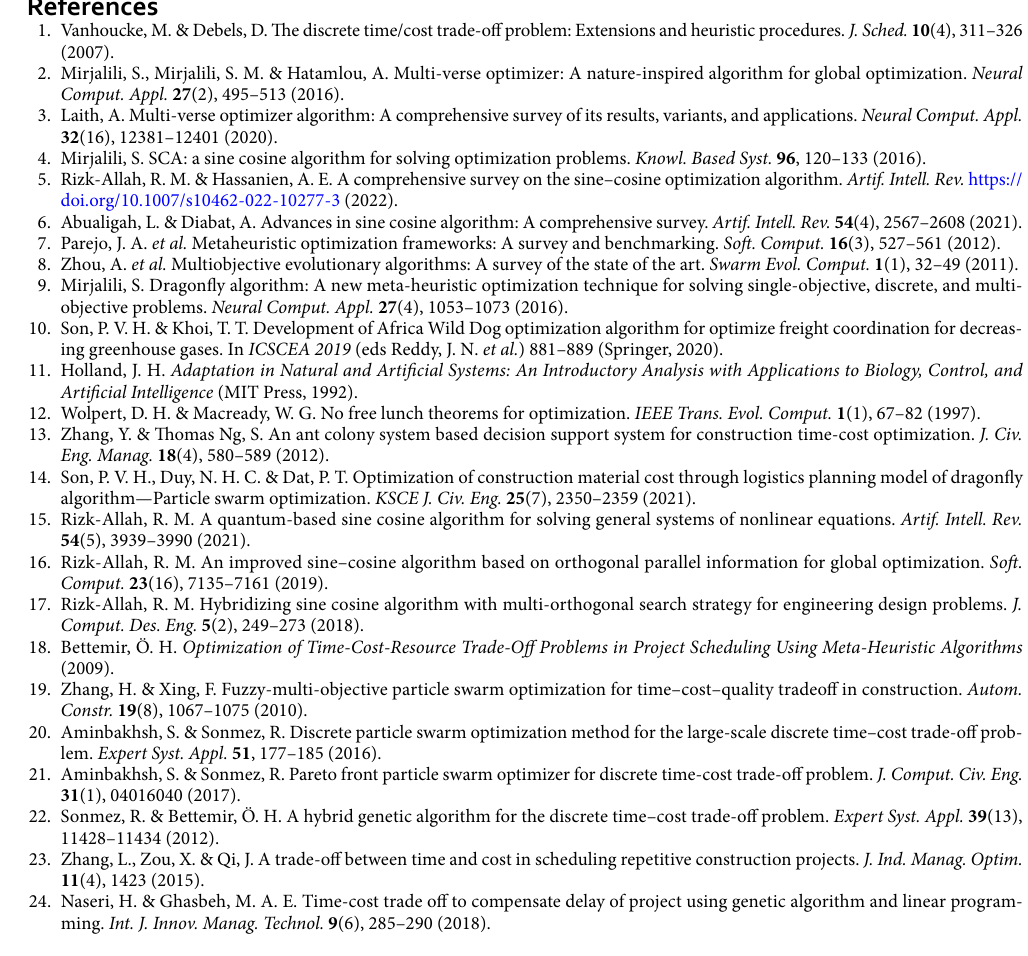
algorithm—Particle swarm optimization. KSCE J. Civ. Eng. 25 (7), 2350–2359 (2021). 15. Rizk-Allah, R. M. A quantum-based sine cosine algorithm for solving general systems of nonlinear equations. Artif. Intell. Rev.